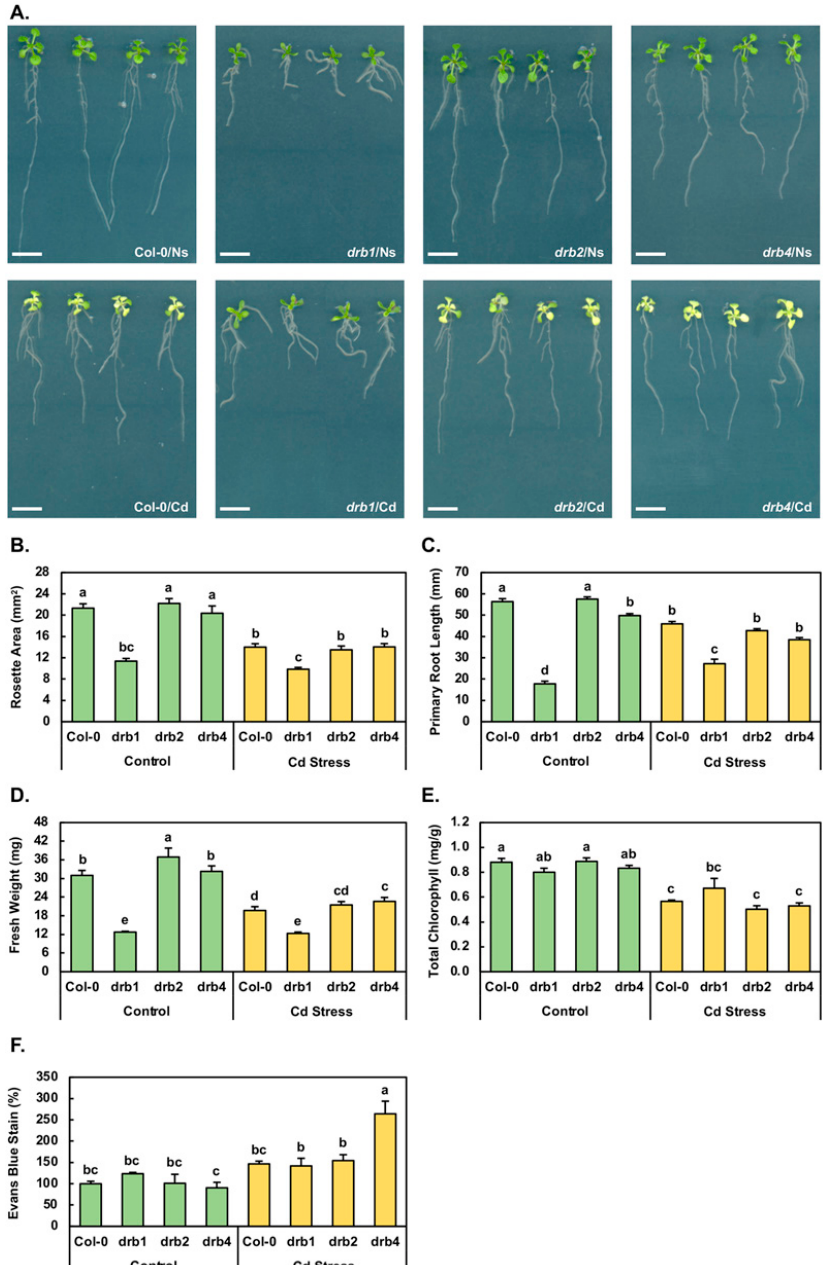
Figure 1. The phenotypic and physiological responses of the Arabidopsis lines Col-0, drb1 , drb2 and drb4 to cadmium stress. ( A ) The phenotypes displayed by 15-day-old control (top panels) and Cd-stressed (bottom panels) Col-0, drb1 , drb2 and drb4 plants. Bar = 1.0 cm. Quantification of the phenotypic parameters, ( B ) rosette area (mm 2 ), ( C ) primary root length (mm) and ( D ) whole seedling fresh weight (mg), of 15-day-old Cd-stressed Col-0, drb1 , drb2 and drb4 seedlings compared to those of the control grown counterpart of each plant line. Determination of the physiological parameters, ( E ) total chlorophyll content (mg/g FW) and the ( F ) degree of cell membrane damage (presented as a percentage (%) of the absorbance of the Col-0/Ns sample at wavelength 600 nm), as determined by spectrophotometry of control and Cd-stressed Col-0, drb1 , drb2 and drb4 seedlings. ( B – F ) Statistical data were analyzed using one-way ANOVA and Tukey’s post-hoc tests. The statistically significant differences are indicated by a different letter ( p- value < 0.05) above each column of each histogram.